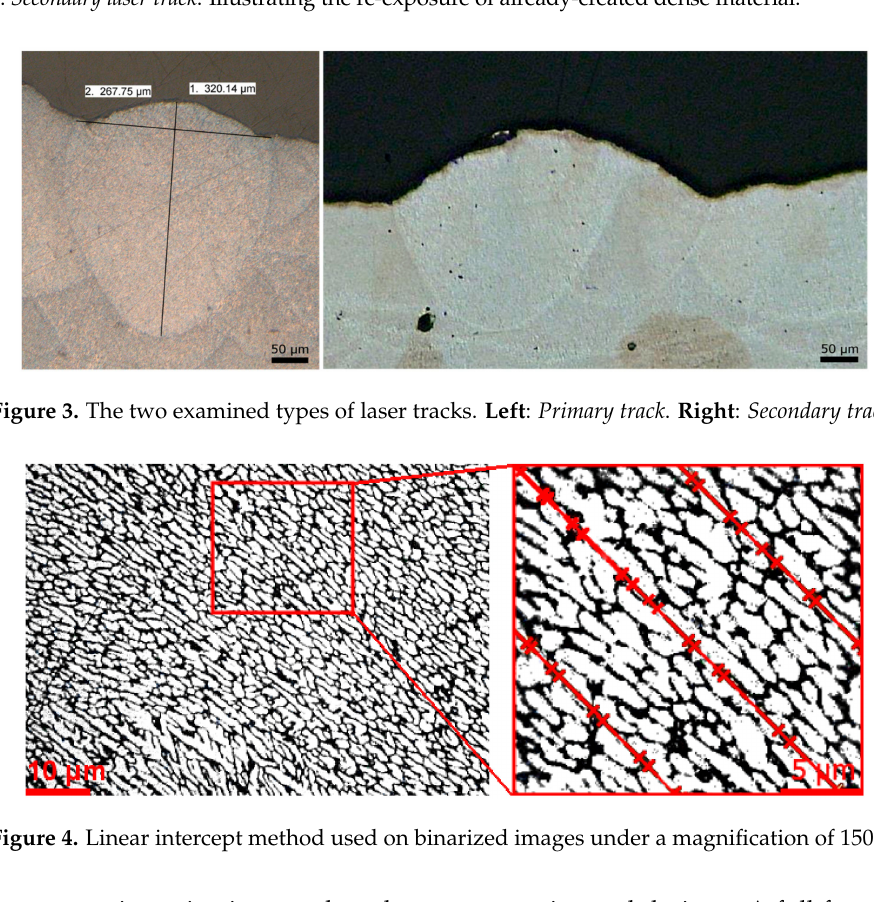
Figure 2. The two examined cases under different thermal boundary conditions. Left : Primary laser track . Illustrating the first exposure and melting of powder particles covering one layer thickness of 90 µ m. Right : Secondary laser track . Illustrating the re-exposure of already-created dense material.